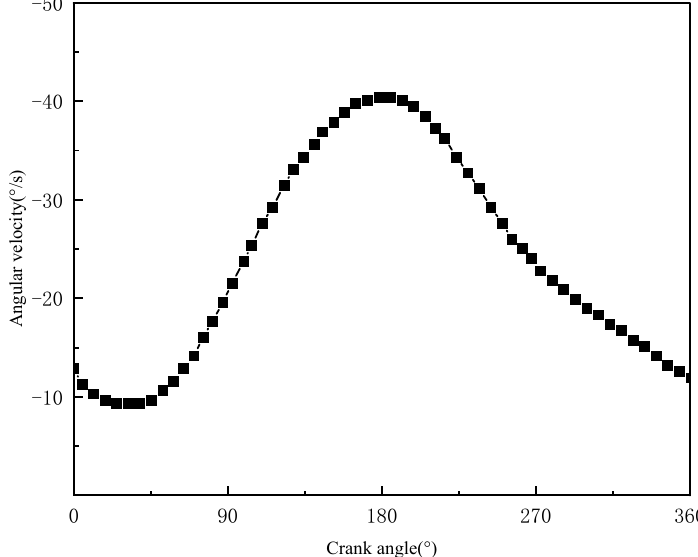
Figure 12. The displacement, velocity and acceleration of suspension. Figure 13 shows the torque superposition curve on the output shaft of the gearbox. It can be seen that the net torque curve after primary balance has negative values around 0°and 360°; the secondary balance torque curve and the torque curve after primary balance are perfectly superimposed such that the maximum value of net torque decreases, the minimum value becomes larger, the negative value becomes positive. The net torque on the output shaft of the gearbox after secondary balance achieves a full-cycle positive value, which proves the feasibility of the principle and basic structure of this transformation scheme.